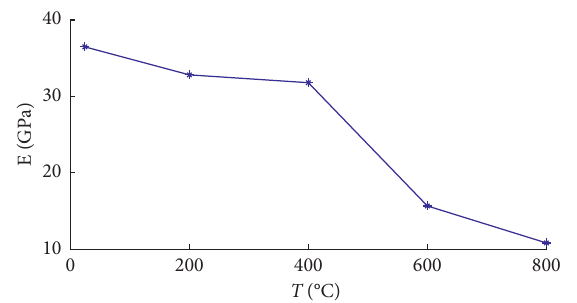
Figure 10: Relationship between elastic modulus and